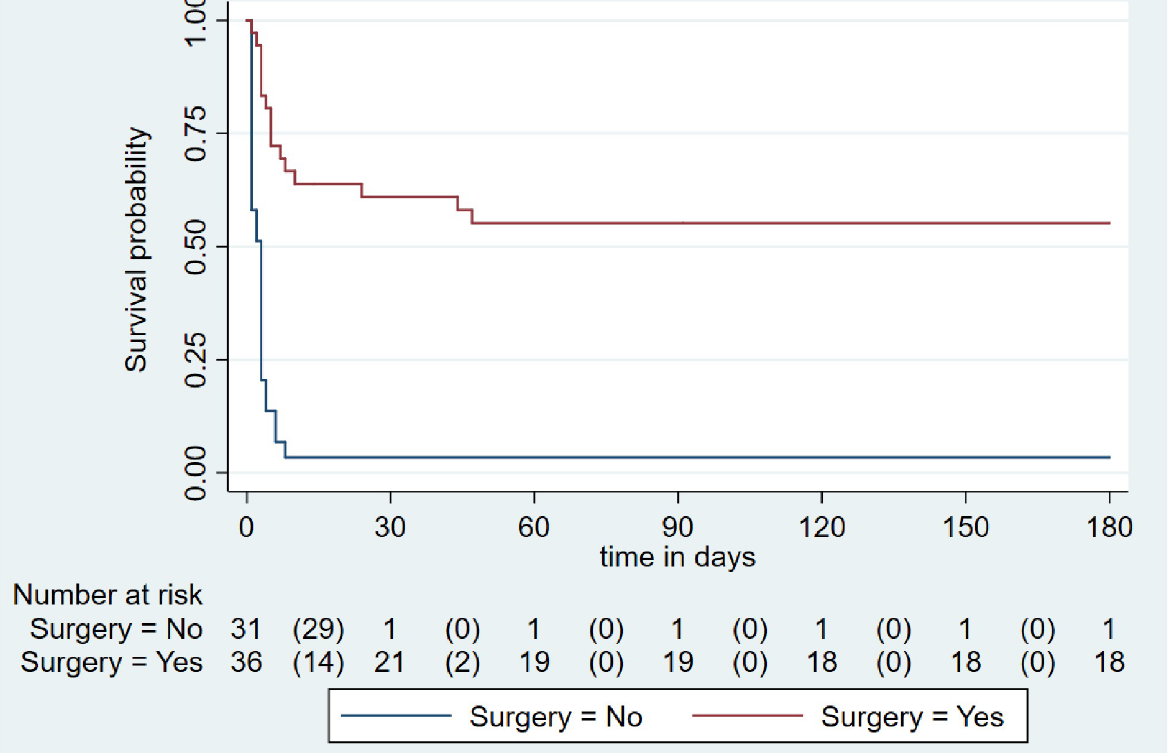
Fig 2. Kaplan-Meier survival curve of operated and not operated VSR patients (n = 67).